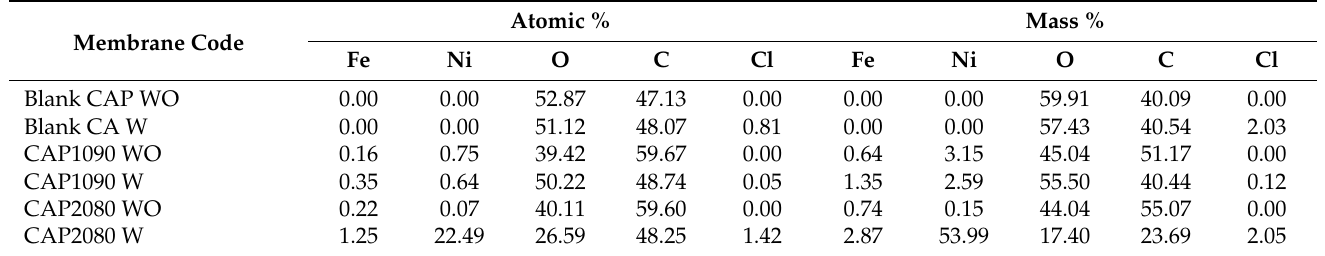
Table 3. EDX analysis of the fabricated blank CA and magnetic mixed CA matrix membranes using SEM equipment.